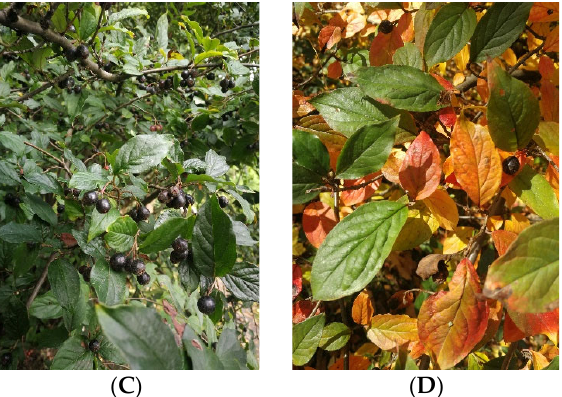
Figure 1. Photos of C. hsingshangensis under study collected in: ( A ) May, ( B , C ) September, and ( D ) October.